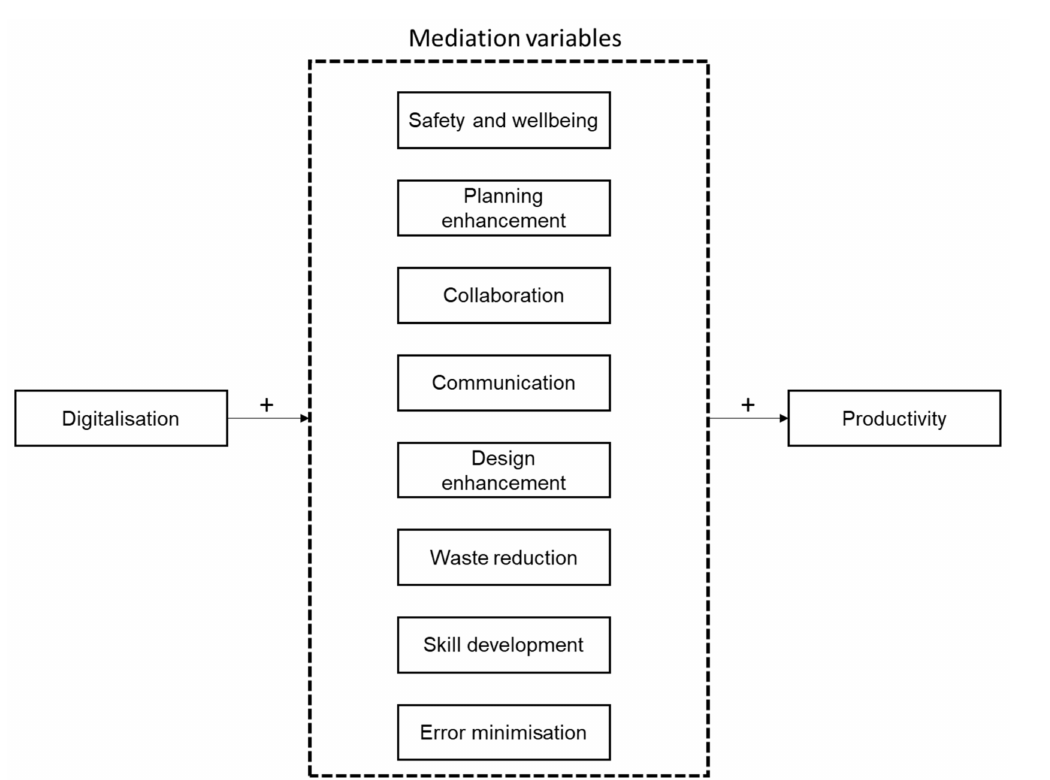
Figure 6. Conceptualisation of the mediators between digitalisation and